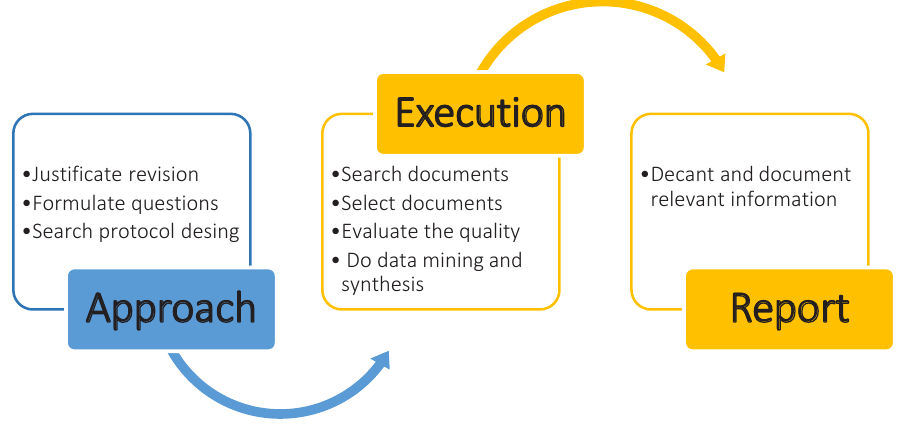
Figure 2. Methodological